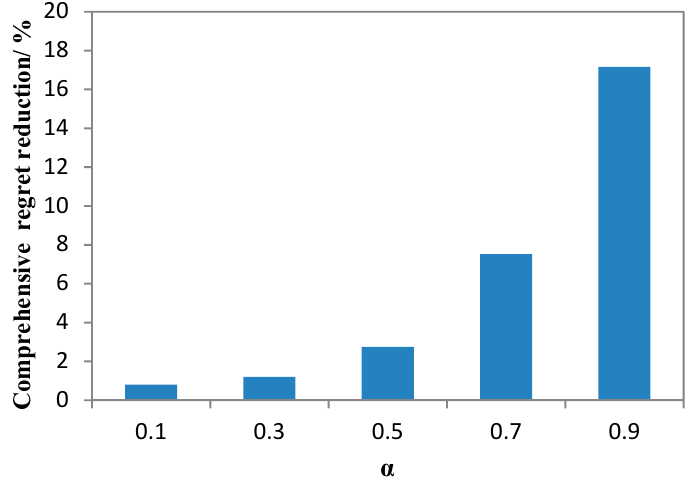
Figure 9. Comprehensive regret reduction between case1 and case 2 under different minimum–maximum regret aversion objective weights, α .